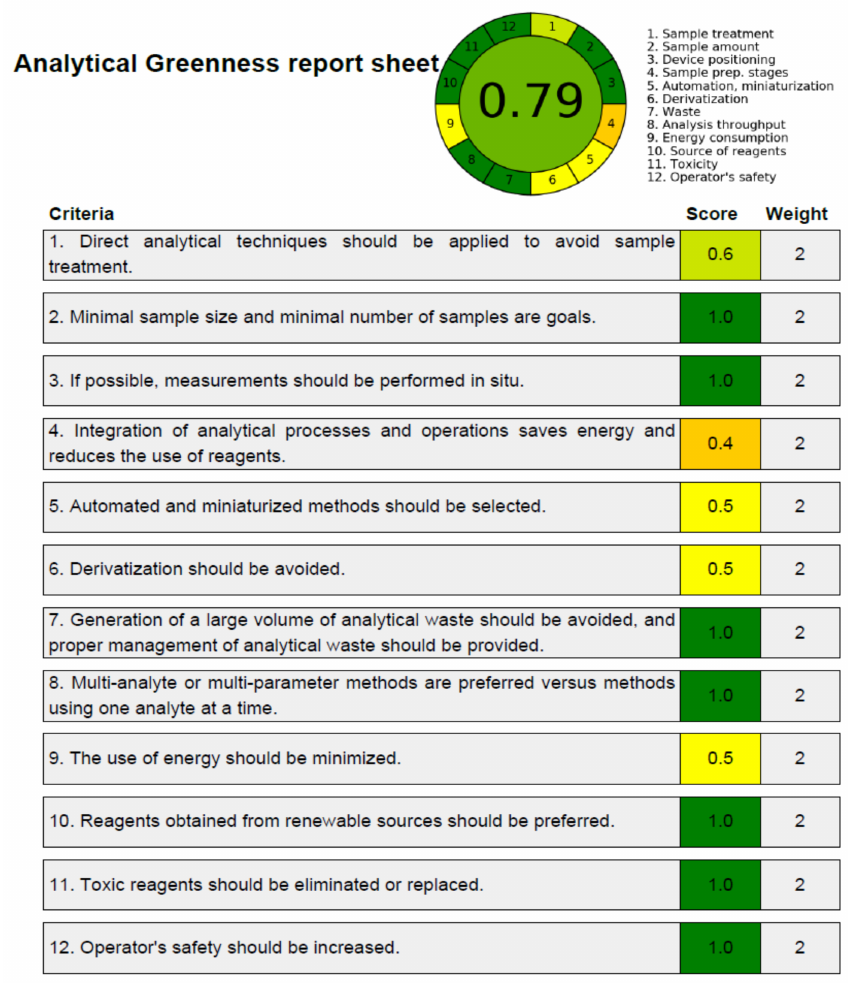
Figure 8. AGREE scale sheet for the greener normal-phase HPTLC approach of thymol, demonstrat- ing the AGREE scale for 12 different components/principles of